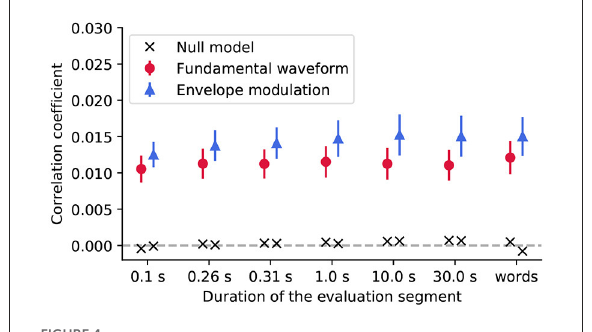
FIGURE4 We evaluated the reconstruction of the stimulus features from the EEG recordings using segments of different duration, including segments aligned with the word boundaries ( words ). For each segment duration, the population-averaged reconstruction scores obtained for the fundamental waveform feature are denoted with red circles, and for the envelope modulation with blue triangles. The error bars correspond to the standard error of the mean across participants. For both features, the reconstruction scores yielded much higher correlation coefficients as compared to their respective null models (black